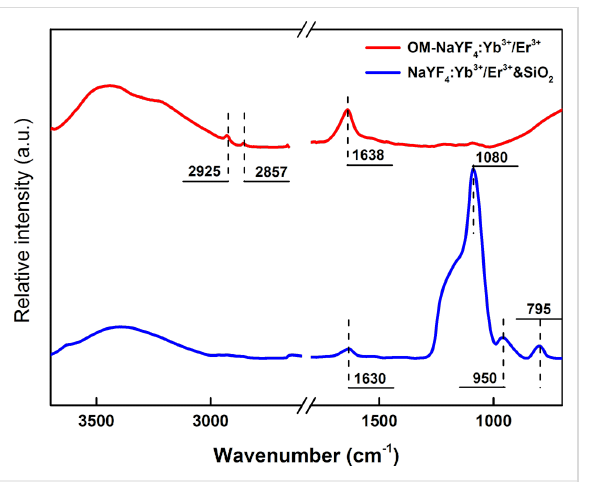
Figure 10: ATR FTIR spectra of OM–NaYF 4 :Yb 3+ /Er 3+ and NaYF 4 :Yb 3+ /Er 3+ &SiO 2